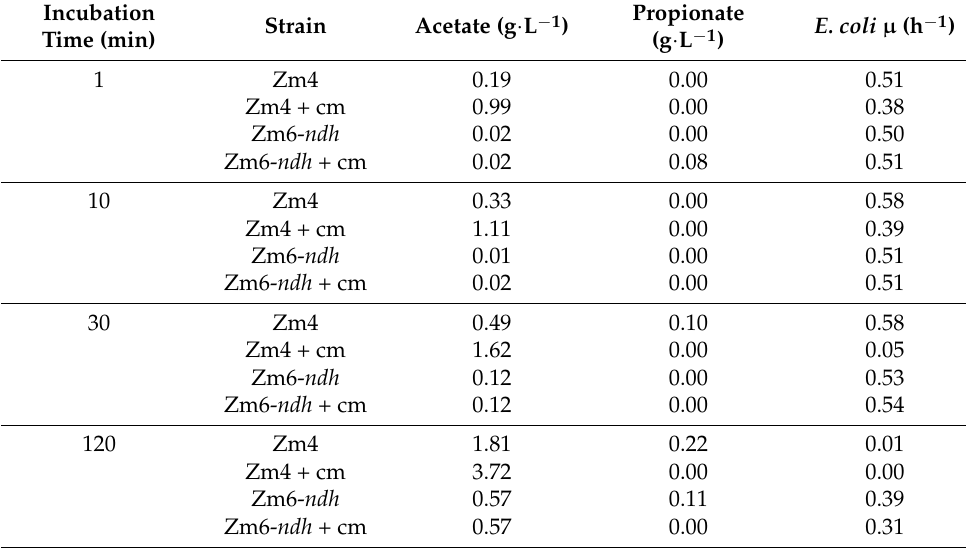
Table 2. Accumulation of acetate and propionate in aerated, nongrowing Z. mobilis cell suspensions consuming glucose, and the effect of their incubation media on the E. coli specific growth rate. Chloramphenicol (cm) was added to Z. mobilis at 100 µ g · mL − 1 final concentration. At indicated timepoints, cells were sedimented, the supernatants were added to the E. coli culture medium at 25% final concentration, and growth of the chloramphenicol-resistant E. coli strain was monitored. Mean values of two replicates are